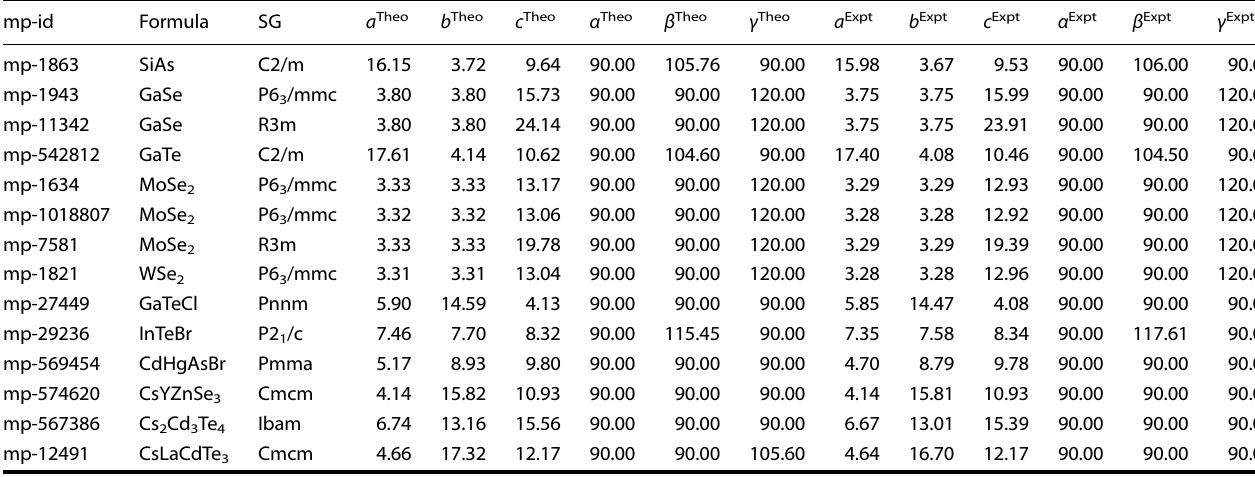
Table 1. Comparison between the computed (Theo) and experimental (Expt) lattice constants ( a , b , c in Å , and α , β , γ in ∘ ), the Materials Project material ids (mp-id) and spacegroup (SG) of all the layered materials considered in this